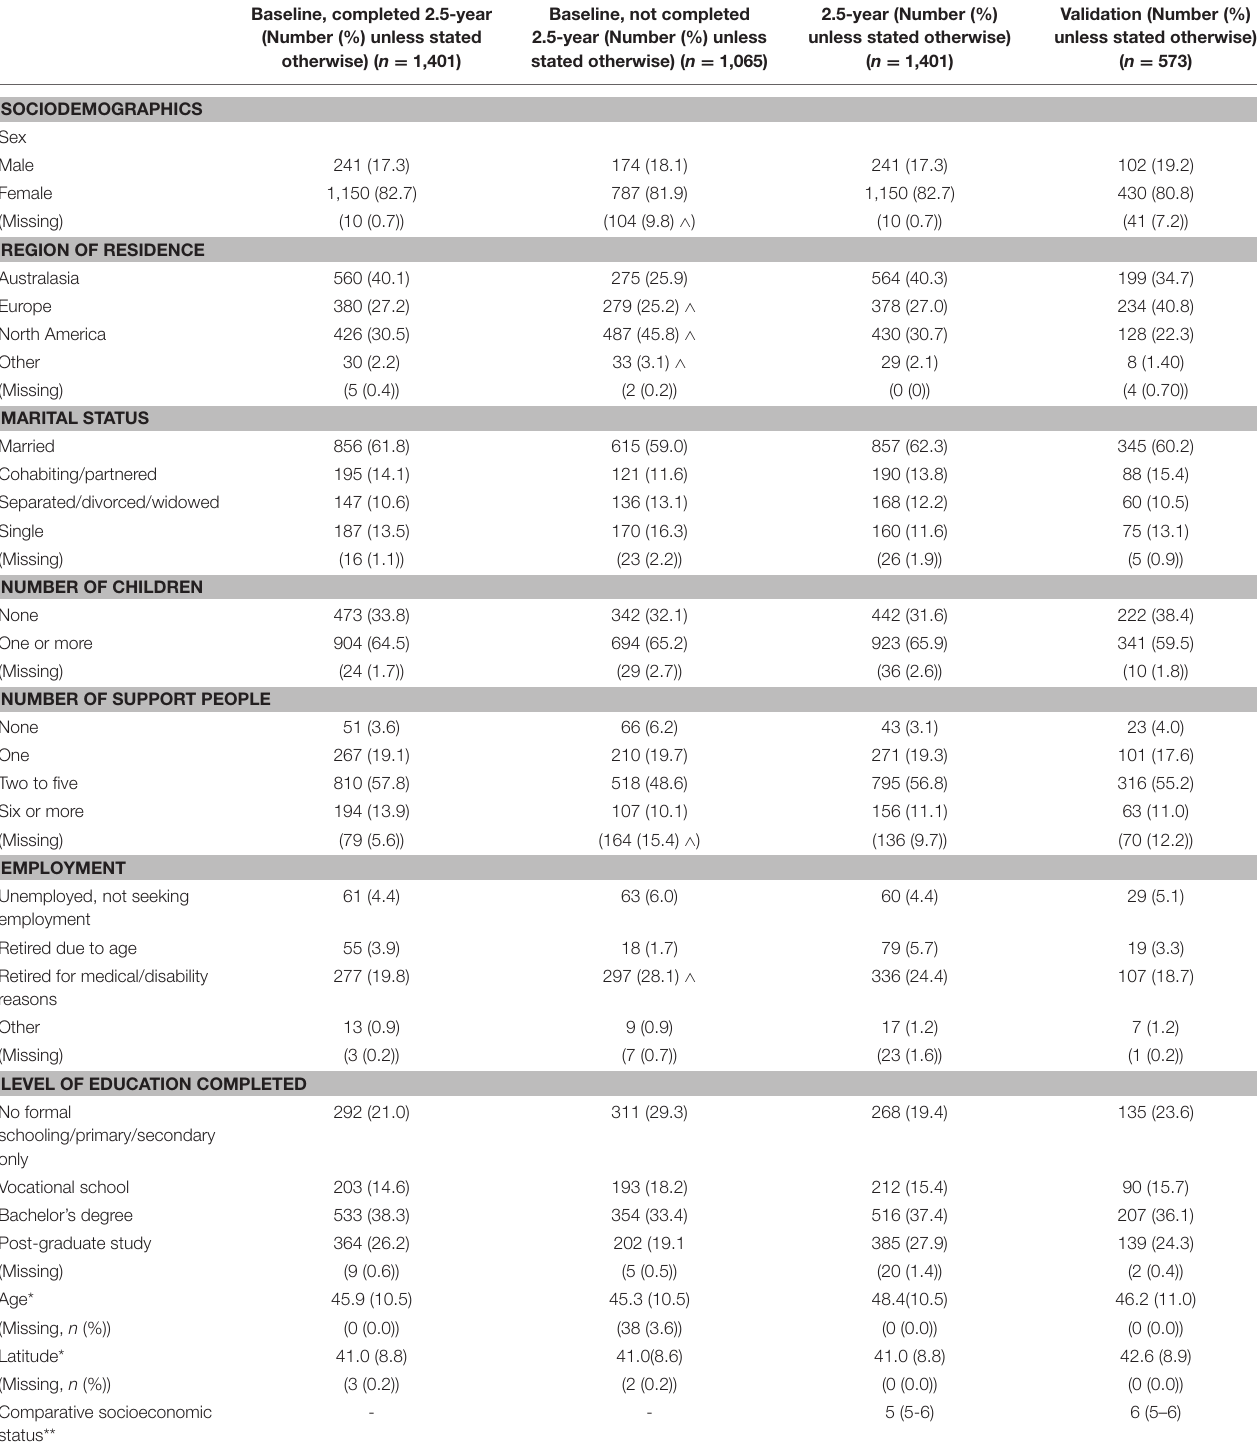
TABLE 1 | Sociodemographic characteristics of the 2.5-year and validation cohorts and the baseline characteristics of the participants who completed and were lost to follow-up at 2.5-year follow-up. Baseline, completed 2.5-year (Number (%) unless